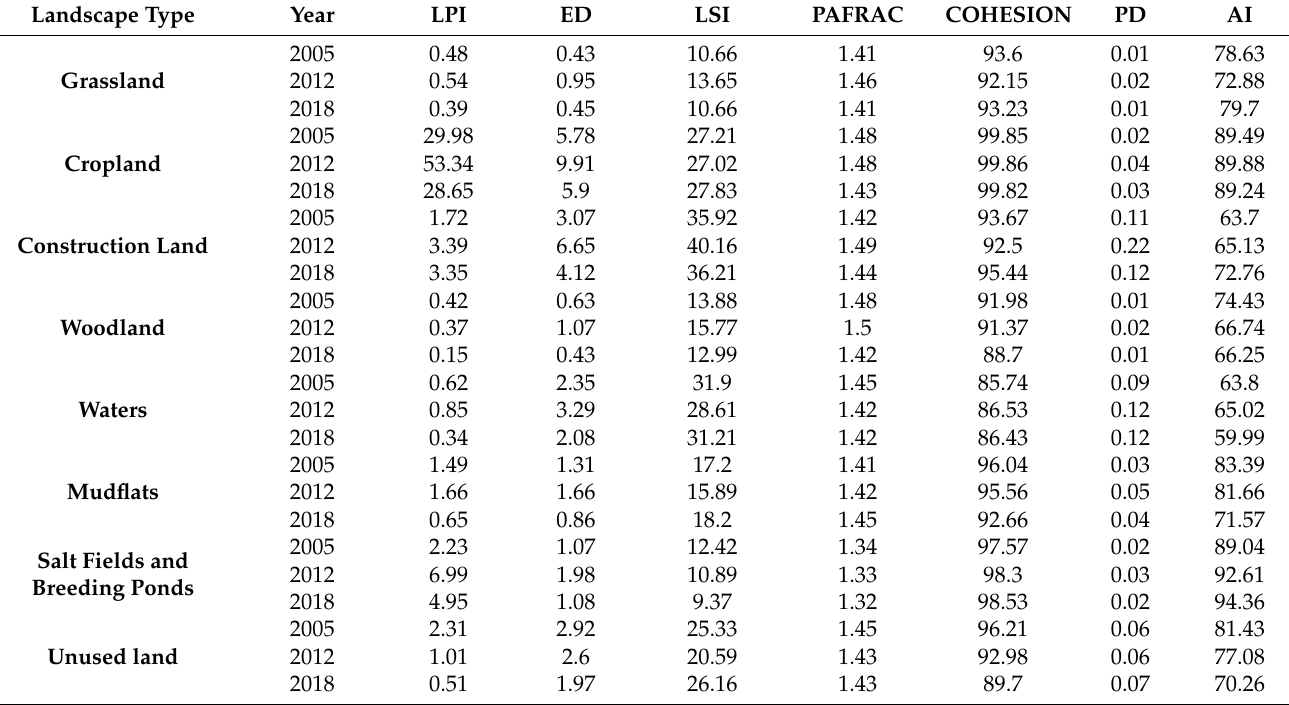
Table 5. Landscape pattern